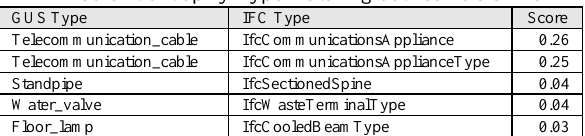
Table 10. Wordnet matching between GUS-IFC GUS